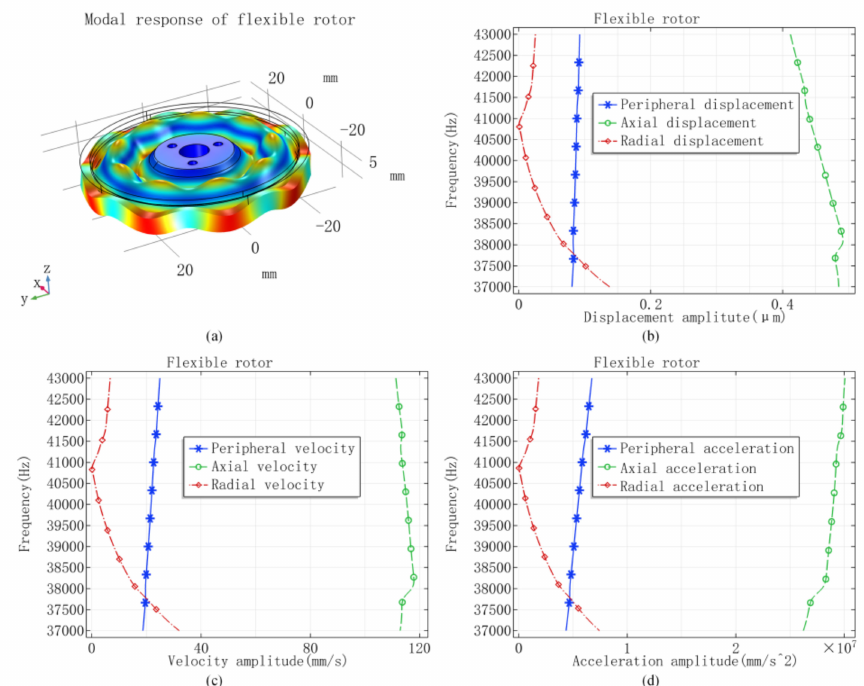
Figure 7. Amplitude response of the flexible rotor in peripheral, axial and radial directions. ( a ) Modal response nephogram of flexible rotor. ( b ) Displacement amplitude versus sweeping drive frequency. ( c ) Velocity amplitude versus sweeping drive frequency. ( d ) Acceleration amplitude versus sweeping drive